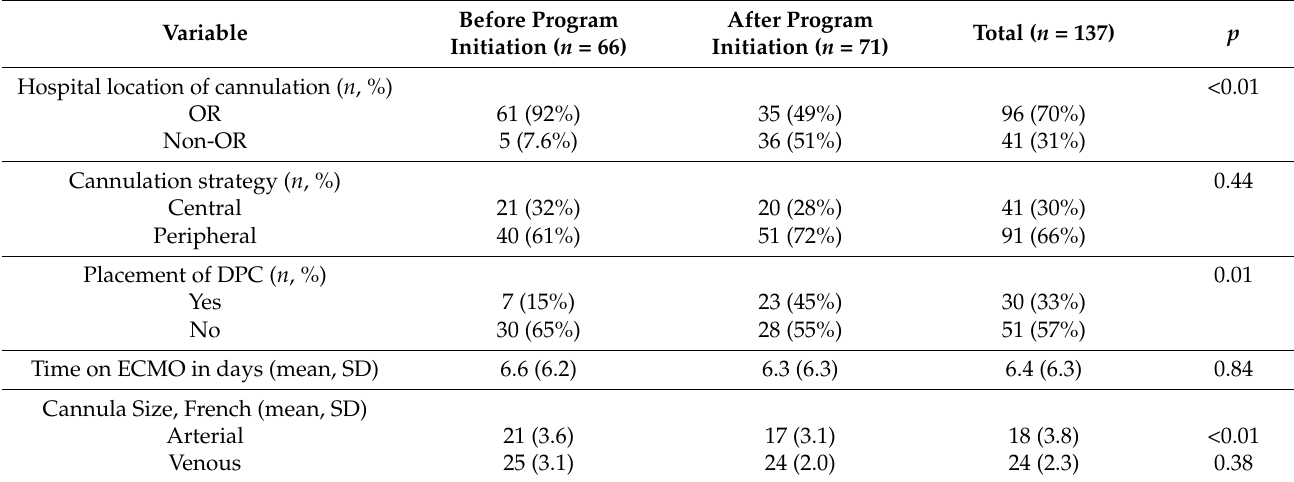
Table 2. Procedural data.